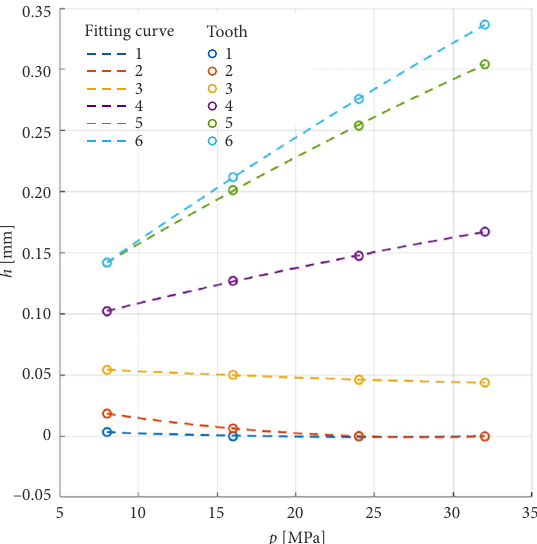
Figure 5. Change of mean gap height as a function of the pressure for the driving gear together with fitting curves